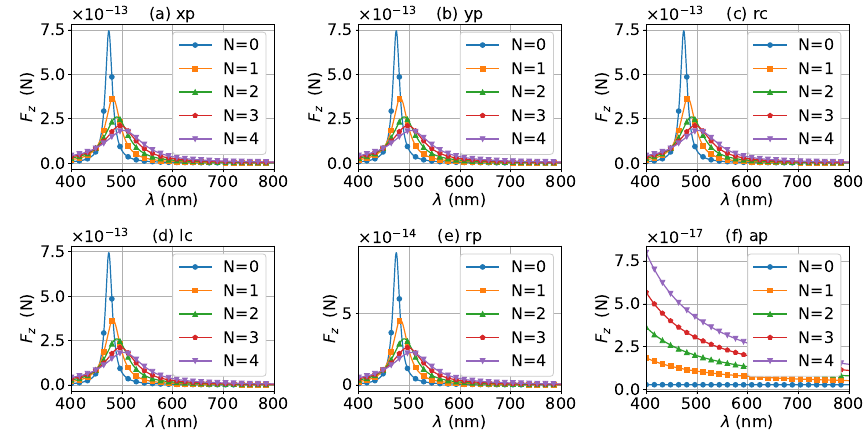
Figure 13. The same as in Figure 12, but with α 0 = 20 ◦